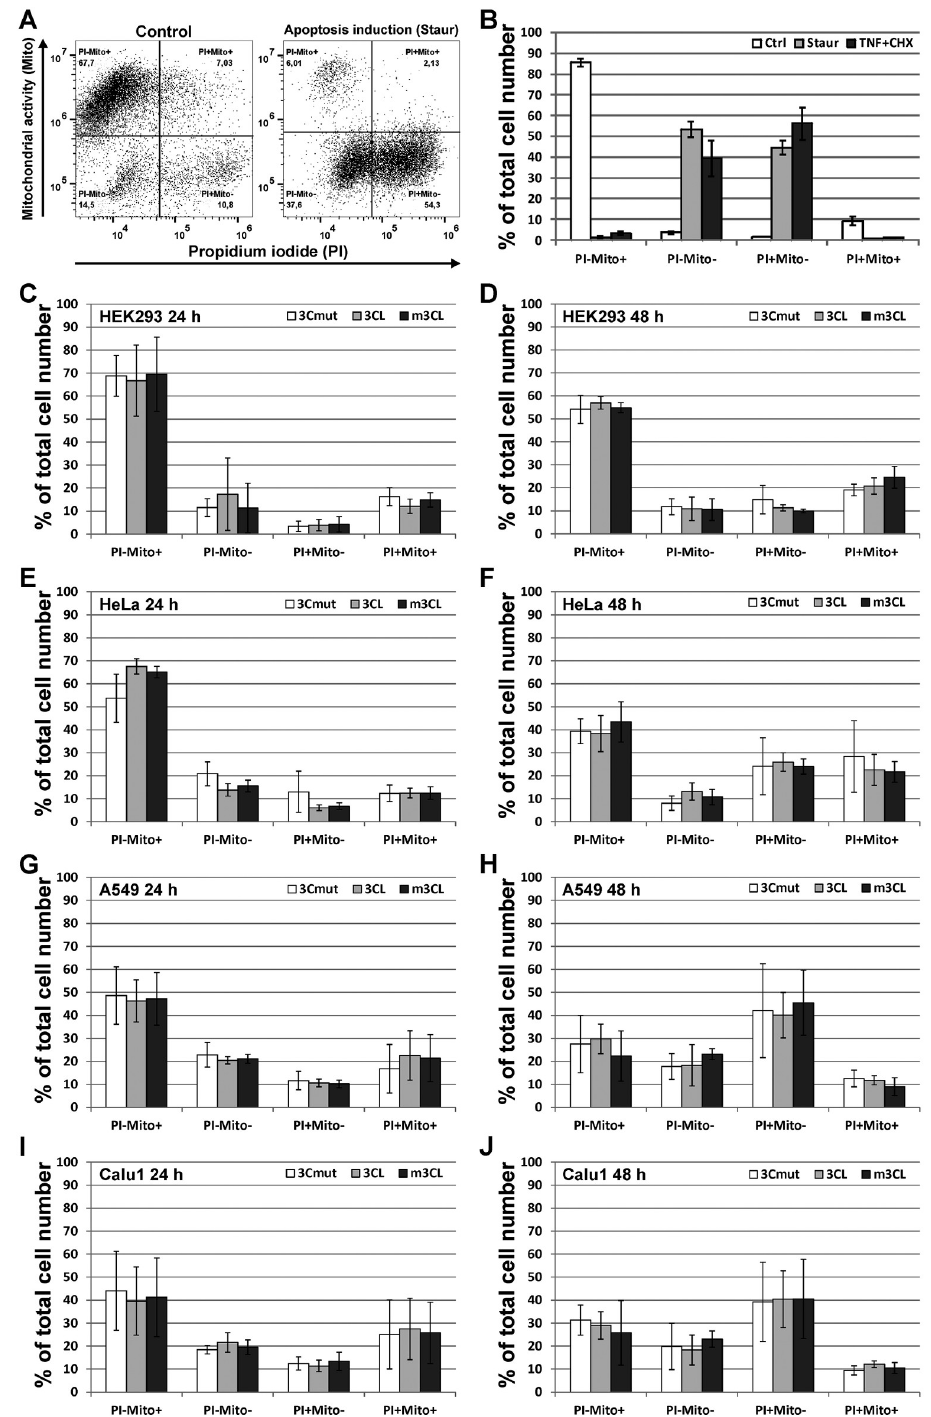
Fig 3. Analysis of the cell viability of transfected cells using flow cytometry. The mitochondrial metabolic activity and membrane integrity of the cells were estimated using 1,1 0 ,3,3,3 0 ,3 0 -hexamethylindodicarbocyanine iodide dye (Mito) and propidium iodide (PI), respectively. Representative dot plots (A) and representative results of the flow cytometry analysis (B) of the control non-transfected A549 cells and A549 cells treated with apoptosis inductors staurosporine (Staur) or tumor necrosis factor α in combination with cycloheximide (TNF+CHX). The cells were transfected with the p3Cmut (3Cmut), p3CL (3CL), and pm3CL (m3CL) plasmids mixed with the pCI-EGFP plasmid (ratio 3:1, respectively) and EGFP-expressing cells were analyzed using Mito and PI at 24 h (C, E, G, I) and 48 h (D, F, H, J) post transfection. Values are represented as mean ± SD of two independent experiments with triplicates (n = 6).